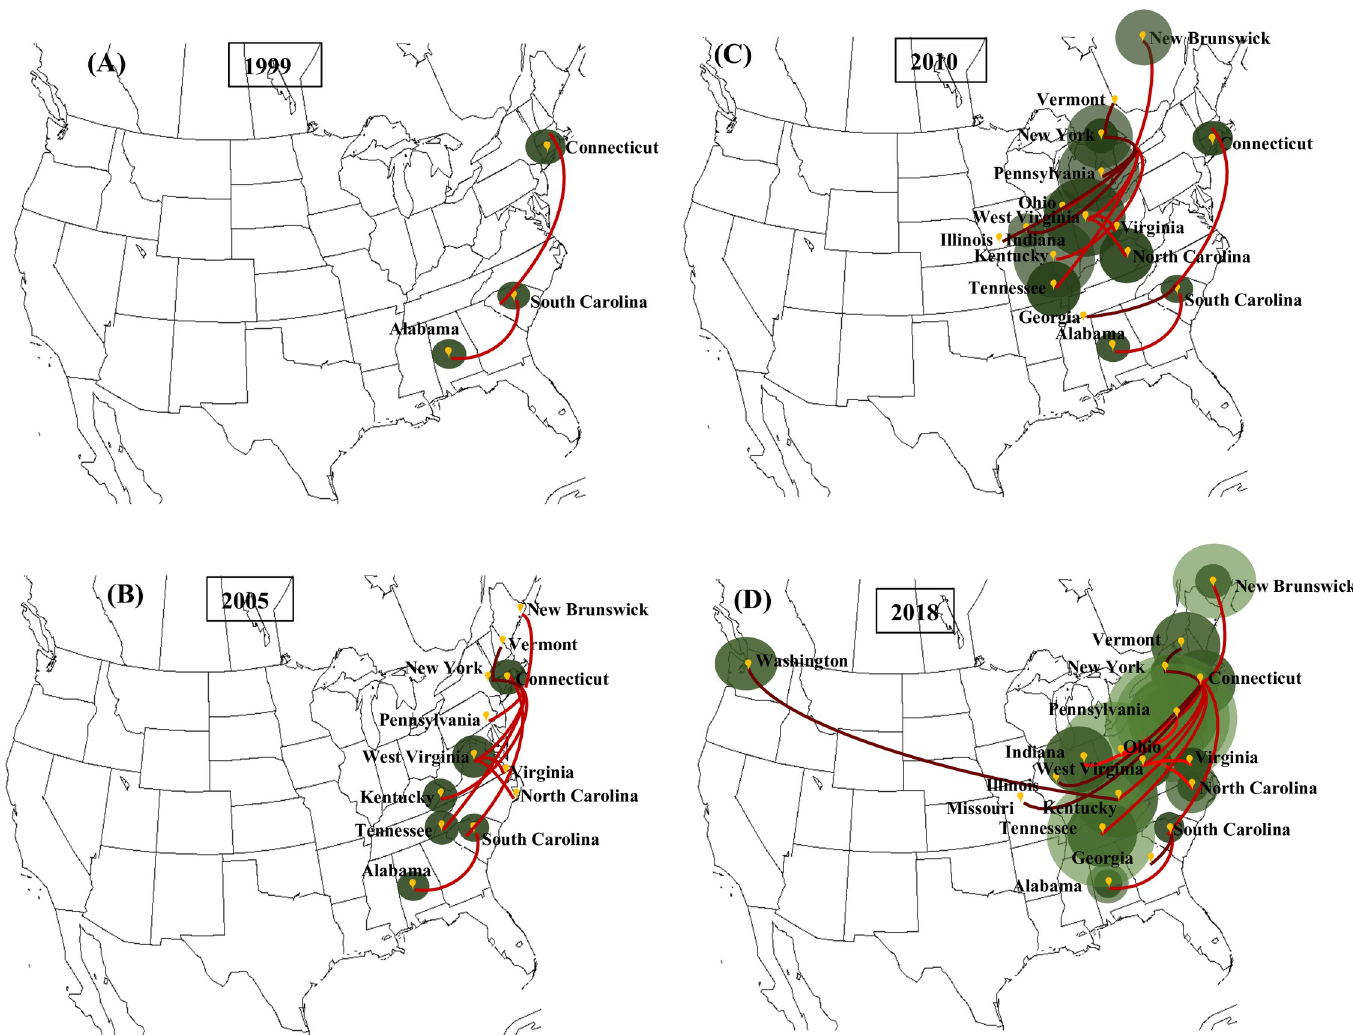
Fig 3. Temporal dynamics of white-nose syndrome spread as inferred from PdPV-pa phylodynamic plotted in Google Earth using SPREAD v1.0.7. Snapshot of (A) spread pattern by 1999, (B) spread pattern by 2005, (C) spread pattern by 2010 and (D) spread pattern by 2018. Lines between the locations represent branch in the maximum clade credibility (MCC) tree. The brightness to the dark color gradient of red indicates the relative age of the dispersal (old to